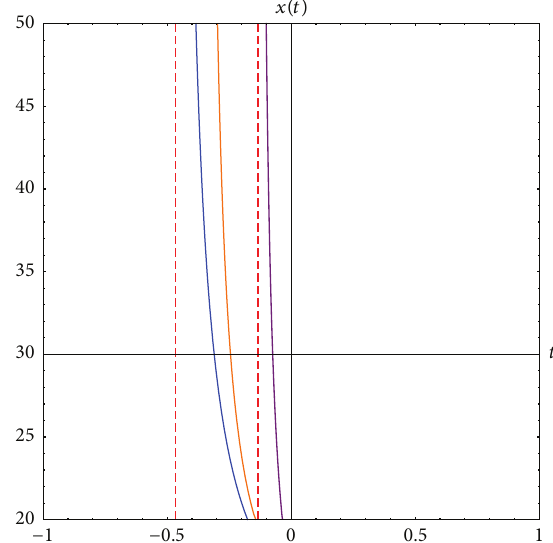
Figure 6: The upper (blue), lower (purple), and solution to (26) (orange), all satisfying the initial condition 𝑥(0) = 16 ; a red dashed vertical asymptote for the upper solution is used for estimating a backward blow-up time.